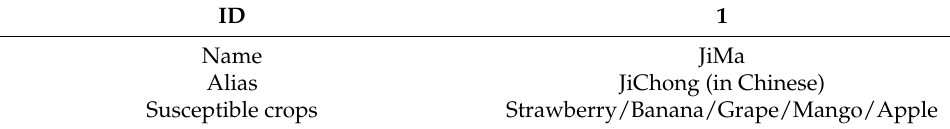
Table 5. Thrip (“JiMa” in Chinese)-related attributes